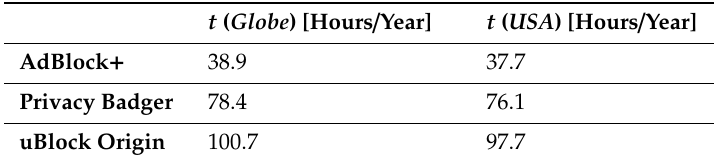
Table 3. Average time per year saved per person who uses the web in the world and the United States if AdBlock + , Privacy Badger, and uBlock Origin were